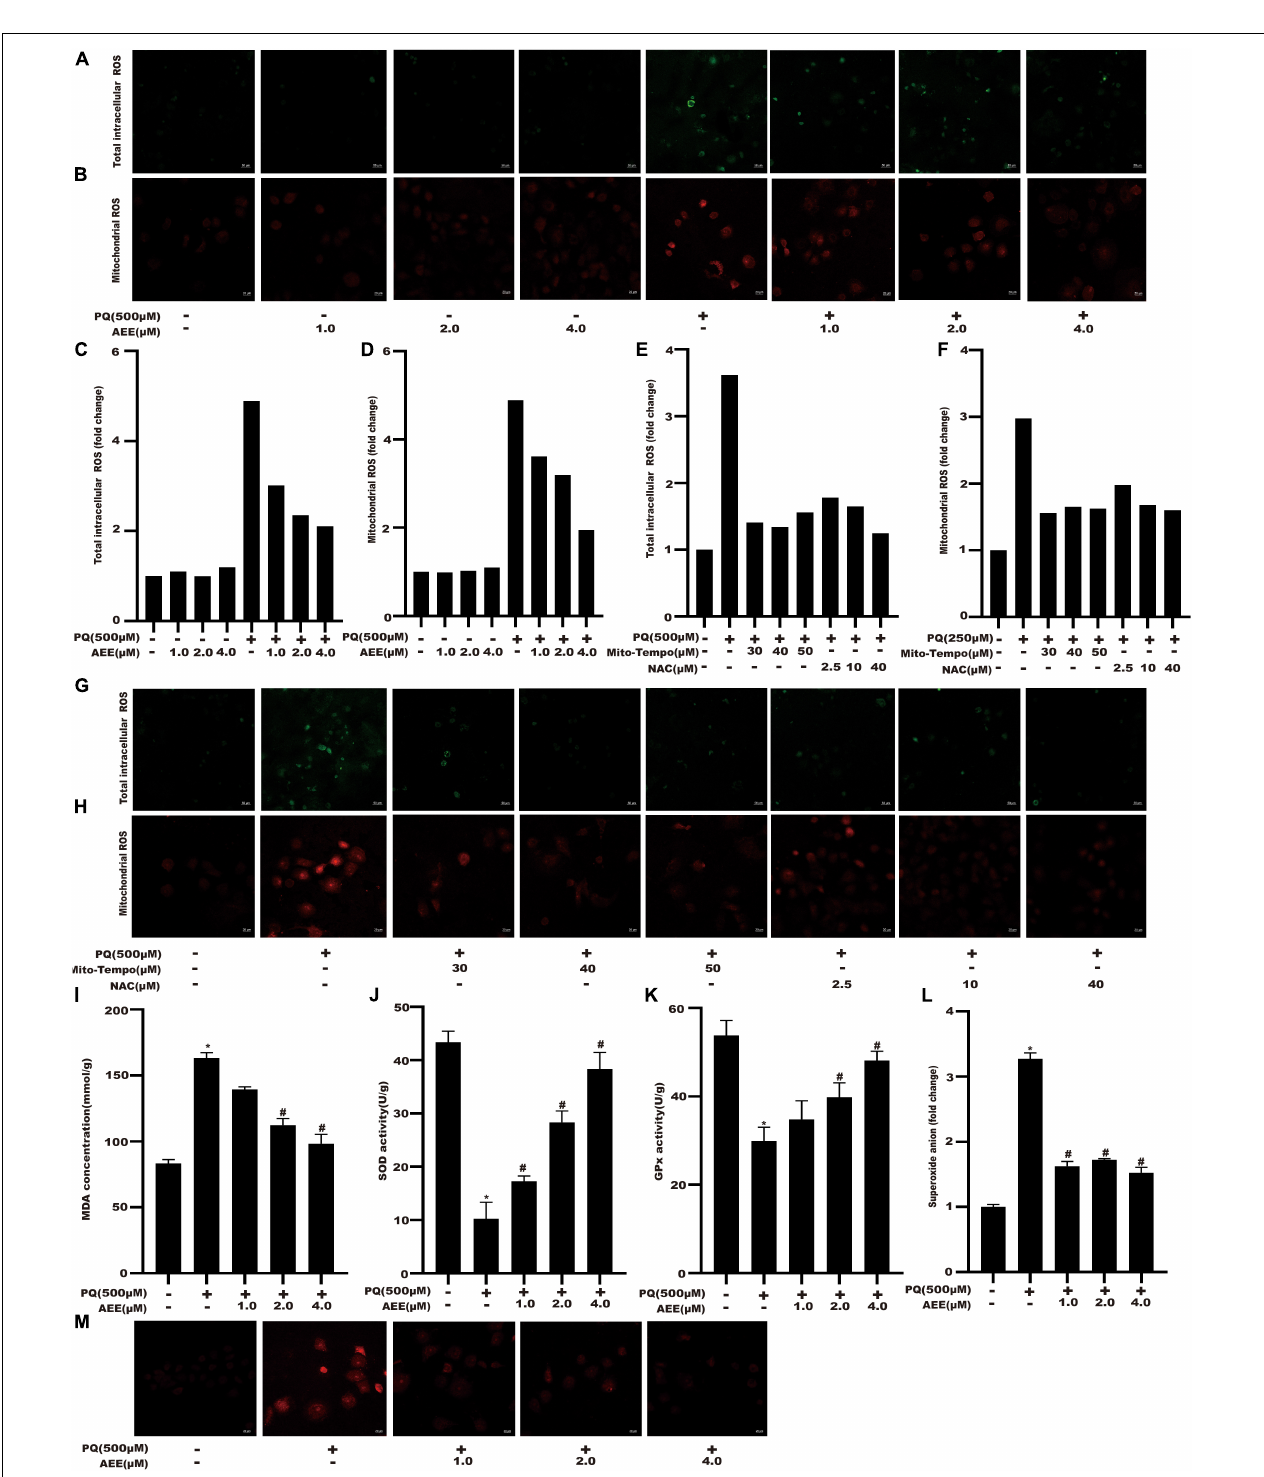
FIGURE 2 | AEE reduces PQ-induced oxidative stress in BRL-3A cells. (A,C) Total intracellular ROS was detected in different treatment groups. Scale bar: 50 µ m. (B,D) Mitochondrial ROS was detected in different treatment groups. Scale bar: 20 µ m. (E,G) Total intracellular ROS was detected in different treatment groups. Scale bar: 50 µ m. (F,H) Mitochondrial ROS was detected in different treatment groups. Scale bar: 20 µ m. (I) MDA levels were detected in different treatment groups. (J) The activity of SOD in different treatment groups was detected. (K) The activity of GPx in different treatment groups was detected. (L,M) The level of superoxide anion was detected in different treatment groups. Scale bar: 20 µ m. The bars display a mean of a number of replicates ( n = 6). * p < 0.05 compared with the control group; # p < 0.05 compared with the PQ group.